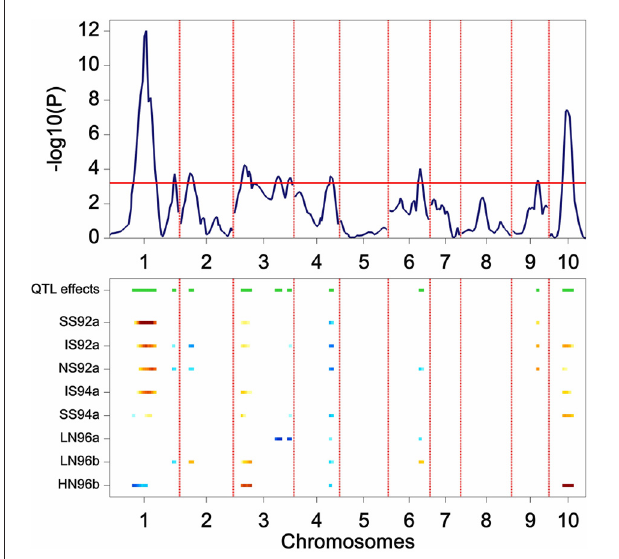
FIGURE 6 | Plot produced by a CIM QTL scan in a maize F2 population. The upper panel shows the P value of the Wald test (on a –log10 scale) for the effect of a QTL along the chromosomes (solid line). The horizontal line indicates a threshold value for significance. The lower panel gives an indication of magnitude of QTL effects (higher intensity, larger effect), and parental line contributing the superior allele (blue, maternal; red, parental